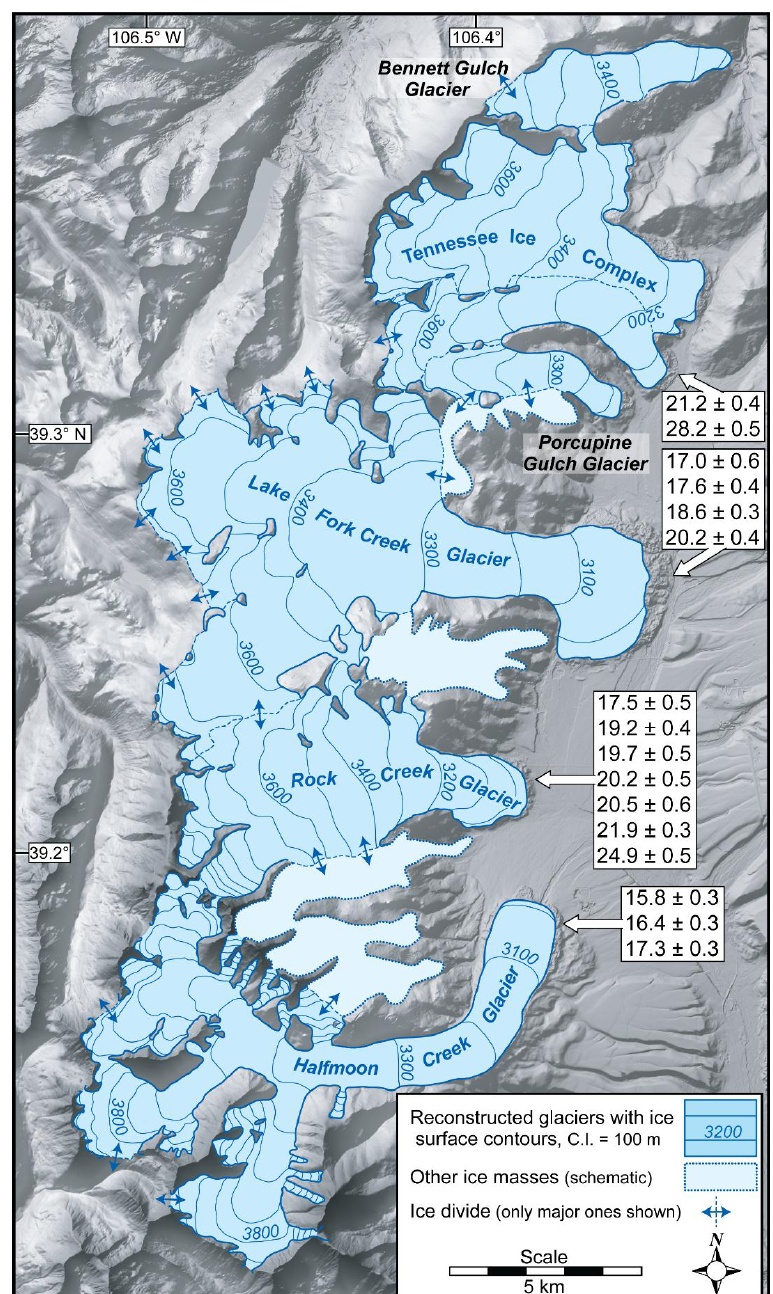
Figure 2. Reconstructed paleoglaciers in the northern Swatch Range and 10 Be ages (ka) on terminal moraine complexes. Basemap was generated from U.S. Geological Survey 10-meter National Elevation Dataset (NED) data and Global Mapper software